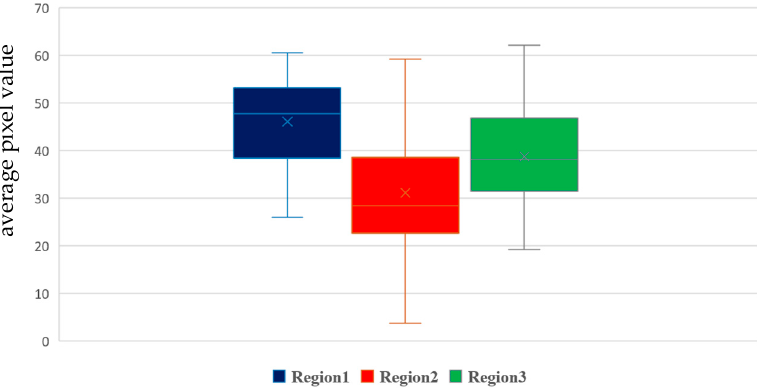
Figure 10. A box plot for three candidate regions of interest.